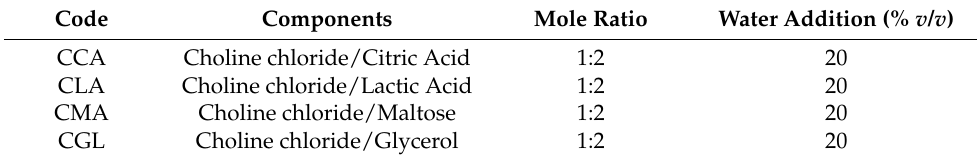
Table 1. Natural deep eutectic solvents (NADES) used in extraction